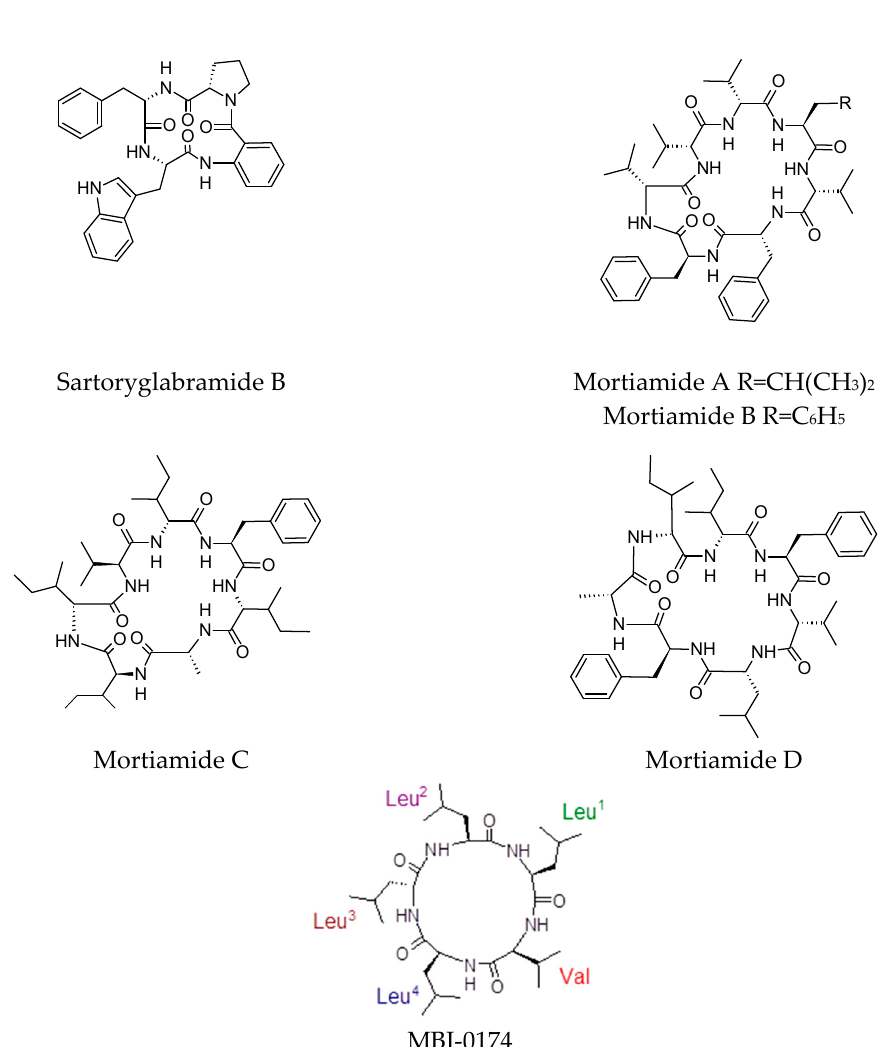
Figure 7. Recently isolated cyclic peptides with no reported biological activity.